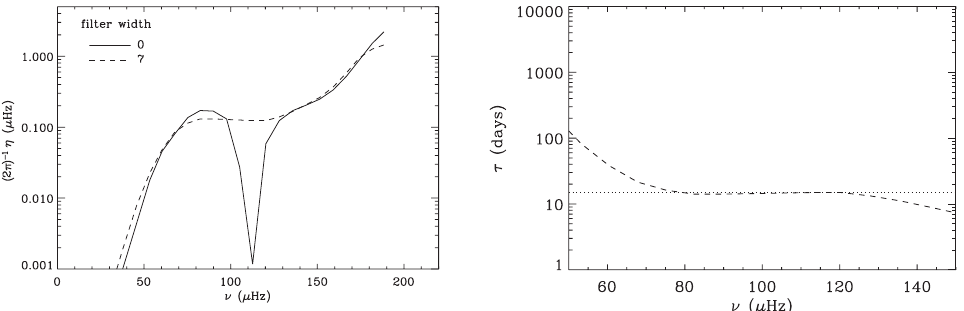
Figure 12: Model computations for the red giant star 𝜉 Hydrae (from Houdek and Gough, 2002). Left panel: The solid curve represents the theoretically predicted linear damping rates as a function of cyclic pulsation frequency. The dashed curve is the result after applying a median smoothing filter with a width in frequency corresponding to seven radial modes. Right panel: Predicted mode lifetime 𝜏 = 𝜂 − 1 (where 𝜂 is in units of angular frequency) for the median-smoothed damping rate (dashed curve) in the left panel. The horizontal dotted line indicates a mode lifetime of 15